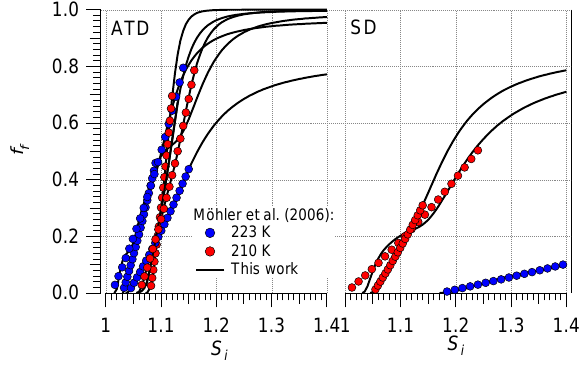
Fig. 7. Heterogeneous ice nucleation spectra in deposition mode for Arizona Test Dust (ATD) and Saharan dust (SD) (Table 2). Lines with the same color indicate runs using different aerosol samples of the same material (M¨ohler et al., 2006).